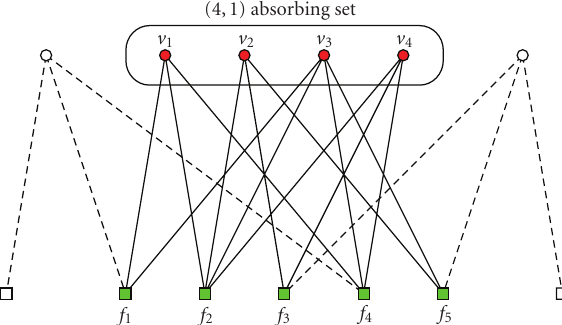
Figure 4: Example of a (4,1) absorbing set in the Tanner graph of an LDPC